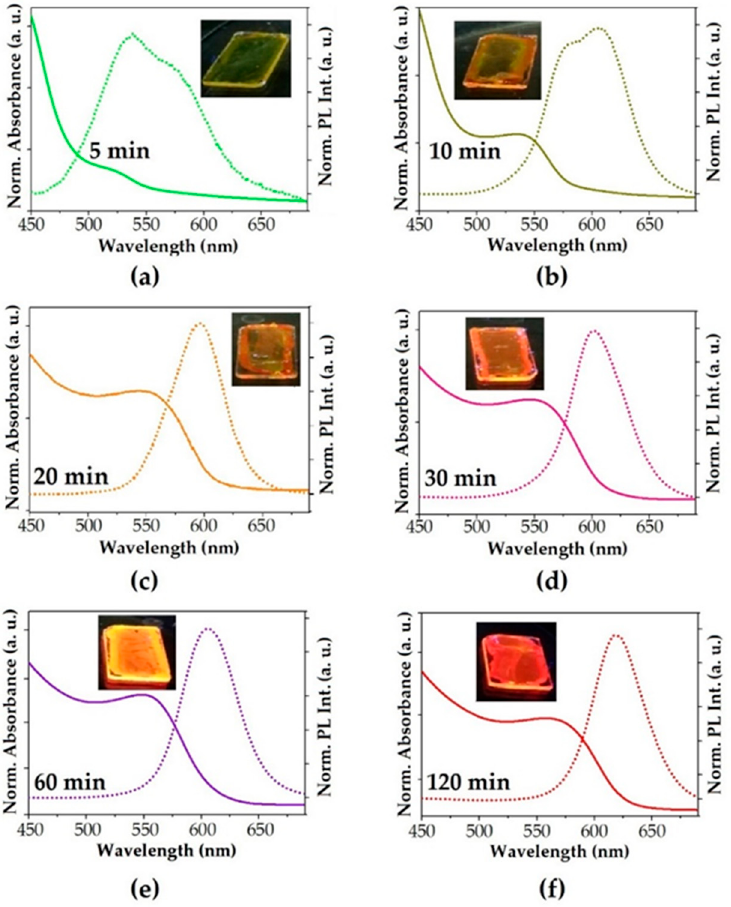
Figure 2. Absorption and normalized PL spectra of films annealed at 150 °C for ( a ) 5, ( b ) 10, ( c ) 20, ( d ) 30, ( e ) 60, and ( f ) 120 min under vacuum. Inset: photographs of the films acquired under UV lamp at 365 nm. Table 2. Calculated QDs size (d) and PL bands parameters as a function of the annealing time.